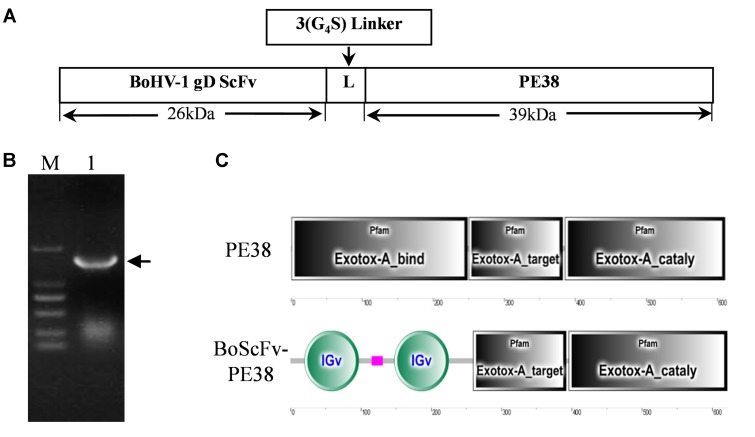
Nucleotide sequence structure of BoScFv-PE38. (A) Schematic diagram of the recombinant immunotoxin BoScFv-PE38. BoHV-1 gD scFv, BoHV-1-specific nanobody; 3(G4S) linker, flexible linkers consisting of glycine and serine residues; PE38, pseudomonas exotoxin A (PE38) protein without the Exotox-A-binding region. (B) The BoScFv-PE38 nucleotide sequence. M represents the DNA molecular weight marker; 1 represents the BoScFv-PE38 nucleotide sequence; and the arrow indicates the size of the BoScFv-PE38 nucleotide sequence. (C) Structural sequence analysis of BoScFv-PE38 and PE38.